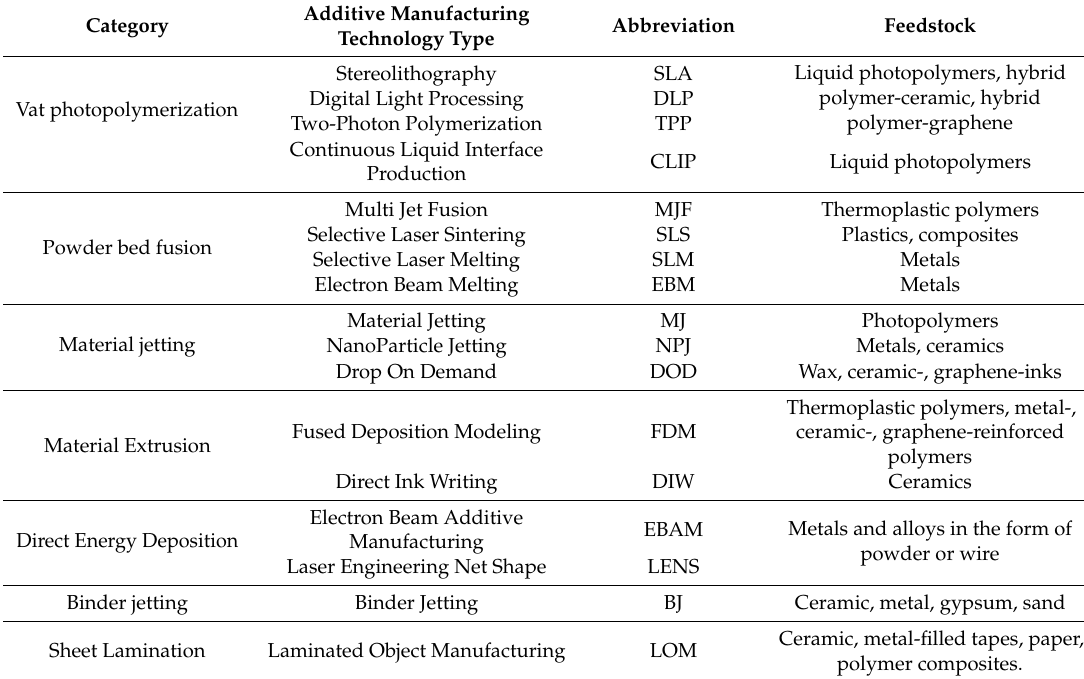
Table 1. Groups of additive manufacturing technologies by the International Organization for Standardization (ISO) / American Society for Testing Materials (ASTM)